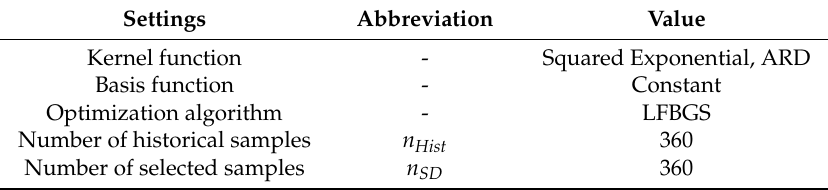
Table 2. Settings for training GPRs to approximate the storage temperatures.